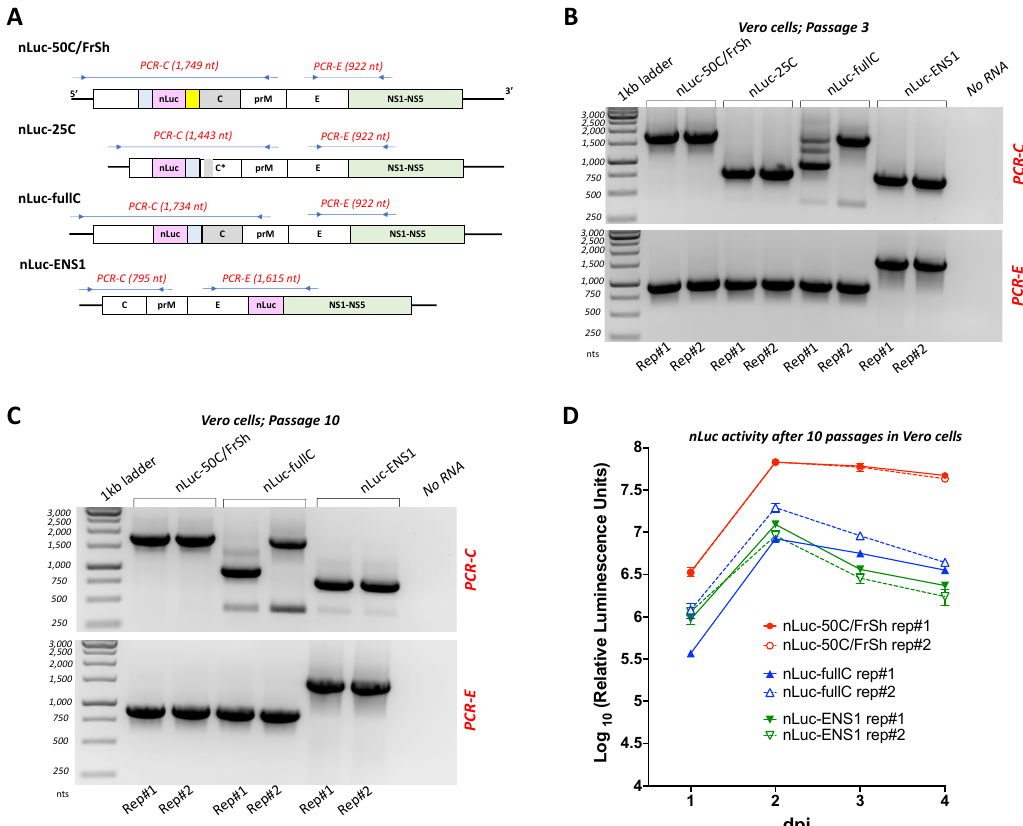
Figure 4. Evaluation of the insert stability of recombinant nLuc-carrying viruses. To compare genome stability of ZIKV-carrying nLuc, blind passaging was performed for all four viruses in 12.5 cm 2 flasks of Vero cells in duplicates, and RT-PCR reactions targeting the regions of nLuc insertion were carried out at multiple points during the experiment followed by sequencing. ( A ) Schematic representation of the positions of primers (represented by arrows) and expected lengths of corresponding RT-PCR fragments. ( B , C ) Agarose gel electrophoreses of RT-PCR fragments produced using viral RNA extracted from duplicate flasks of Vero cells (Rep#1 and Rep#2) after passage three (panel B) and ten (panel C). For each virus, two RT-PCR reactions were carried out (PCR-C and PCR-E, indicated in red), amplifying the region of nLuc gene insertion and selected region of ZIKV genome. Amplification of the viral regions that do not contain nLuc insertion serves as control of the expected band sizes after a complete deletion of the heterologous sequences in the nLuc-carrying viruses. Negative template control was included in each experiment and is shown in No RNA lane. Passaging of nLuc-25C was terminated after the third passage due to complete loss of nLuc insertion. ( D ) Kinetics of luciferase activity in Vero cells. Viruses recovered after the tenth passage in Vero cells were used for infection of Vero cells in 24-well plates at an MOI of 0.1. Measurements of nLuc activity in cell lysates were performed daily and data expressed as mean of standardized luciferase units ± standard deviations for the duplicate wells of infected Vero